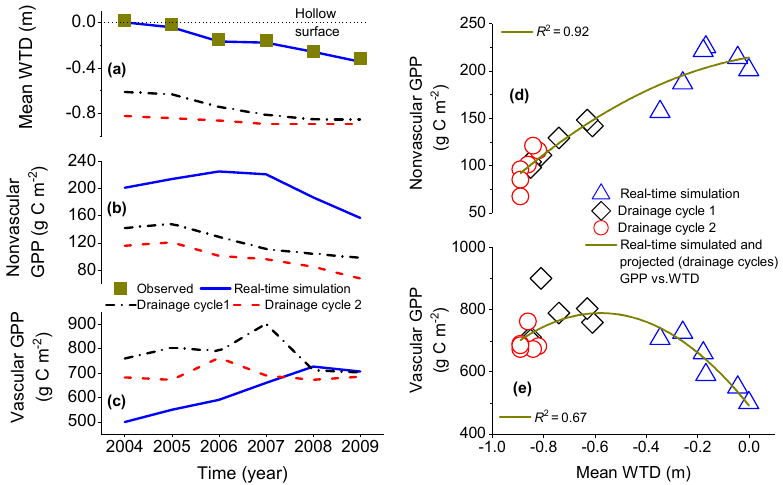
Figure 10. Simulated (real-time simulation) and projected (drainage cycles 1 and 2) (a) average growing season (May–August) WTD, (b) growing season sums of nonvascular (moss) GPP and (c) growing season sums of vascular GPP; regressions ( P < 0 . 001) of simulated and projected sums of (d) nonvascular GPP and (e) vascular GPP on simulated and projected average growing season WTD during 2004–2009 at a western Canadian fen peatland. A negative WTD represents a depth below hollow surface, and a positive WTD represents a depth above hollow